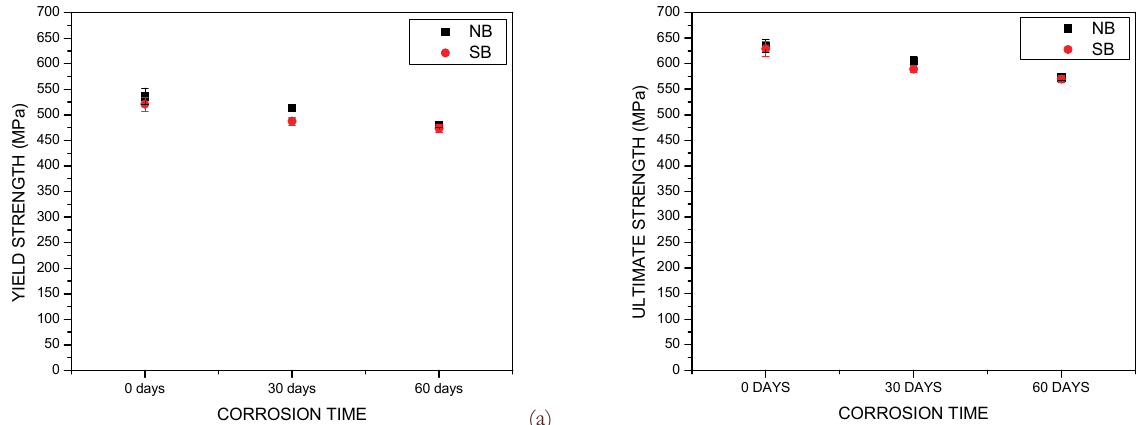
Figure 14: Uniform elongation (a) and strain at break (b) of as-received as well as sandblasted specimen at each corrosion exposure period.